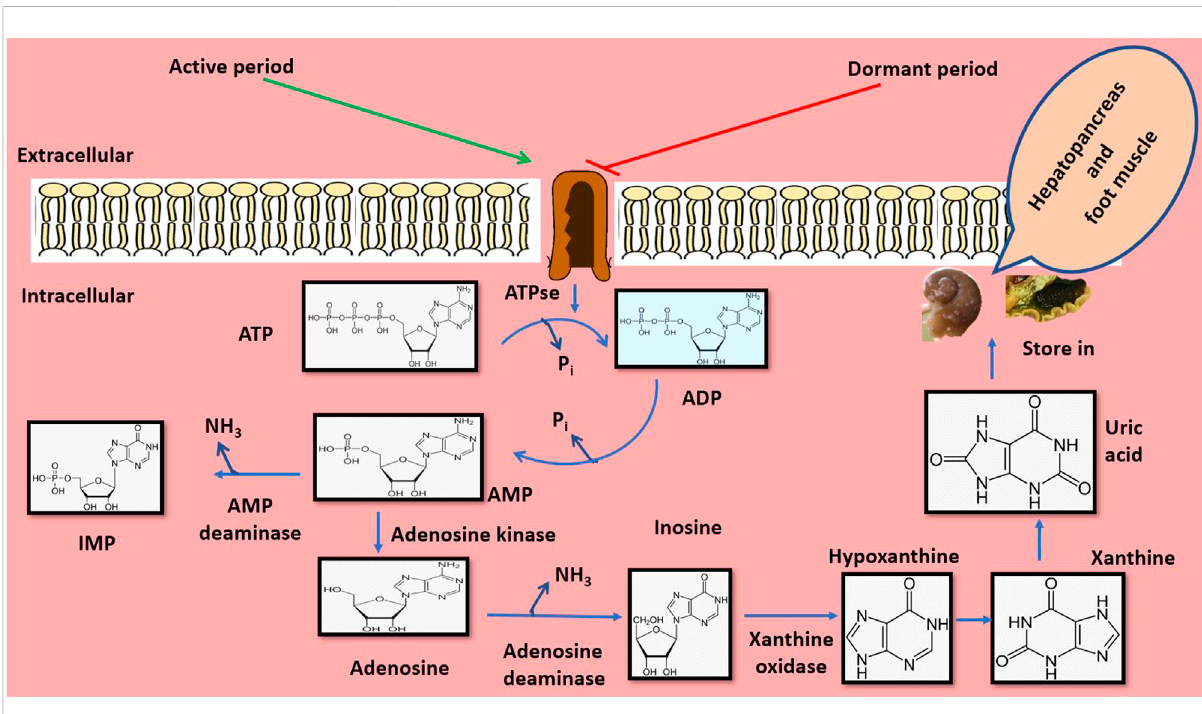
FIGURE 6 Environmental induced alteration of excretory pattern from ammonotelism to uricotelism. During the winter and summer seasons, when temperaturesareextremelylowandextremelyhigh,respectively,theorganismhasatendencytochangeitshabitatfromaquatictoterrestrialduring the dormant period. During the active period, ATP serves as an activator for ammonia formation by converting into AMP. AMP is then transformed into IMP and inosine through the release of ammonia by AMP deaminase and adenosine deaminase enzymes. During dormant periods, the ATPase activity is blocked, so the splitting of ATP is also depleted, which in turn decreases the ammonia concentration, and the organism escapes from ammonia toxicity. Therefore, during dormant periods, the excretory products shift from ammonia to uric acid, which is stored in the hepatopancreas and foot